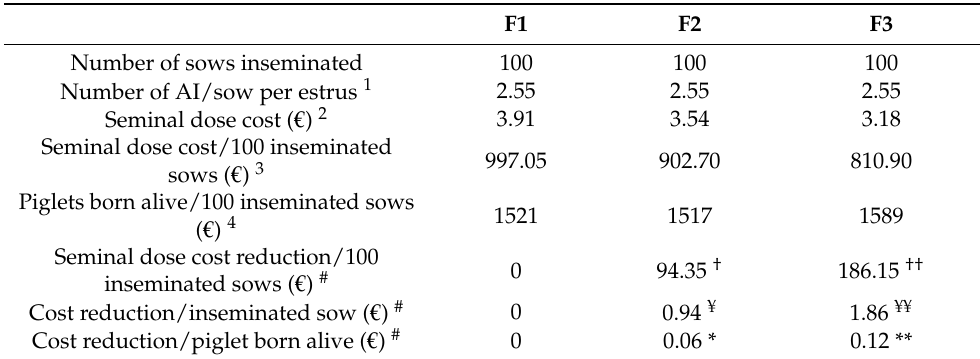
Table 7. Economic comparison between ejaculate fraction/s included in the seminal dose (F1 vs. F2 vs. F3) in terms of cost reduction per AI and piglet born